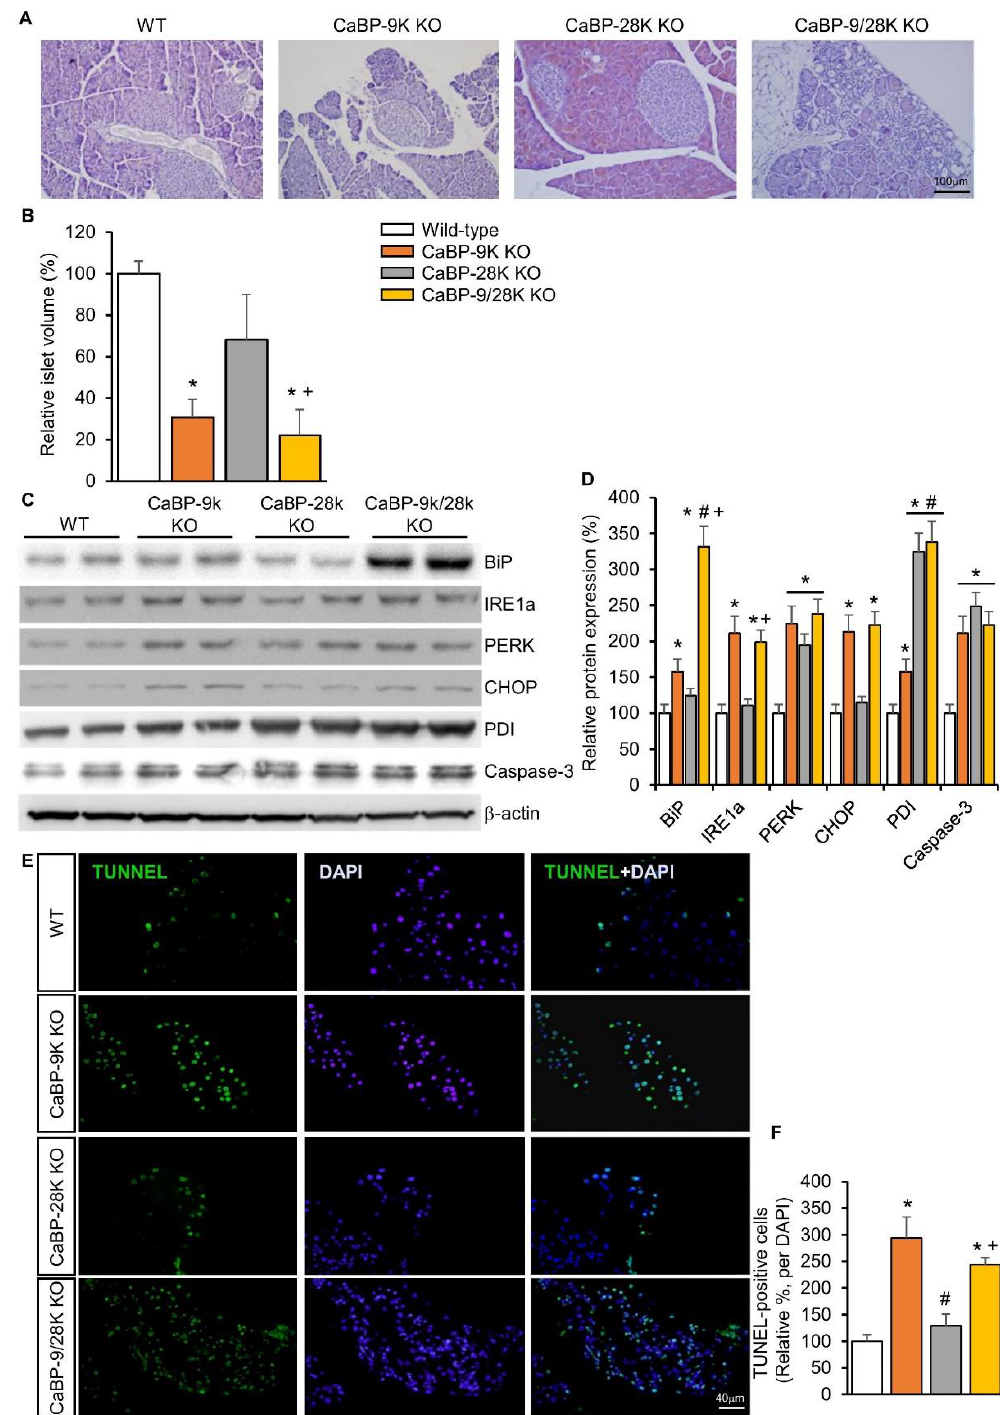
Figure 2. The e ff ects of CaBP-9k, 28k, and 9 / 28k ablation in pancreatic beta cell death. hematoxylin and eosin (H&E) staining in pancreatic tissue ( A ); assessment of beta cell mass in pancreatic tissue ( B ); endoplasmic reticulum stress marker protein expression in pancreas ( C , D ); TUNNEL assay with pancreatic tissue ( E , F ). Values are expressed means ± SDs; * p < 0.05 versus WT; # p < 0.05 versus CaBP-9k KO; + p < 0.05 versus CaBP-28k KO. Scale bar, 100 µ m in ( A ); 40 µ m in ( E ).